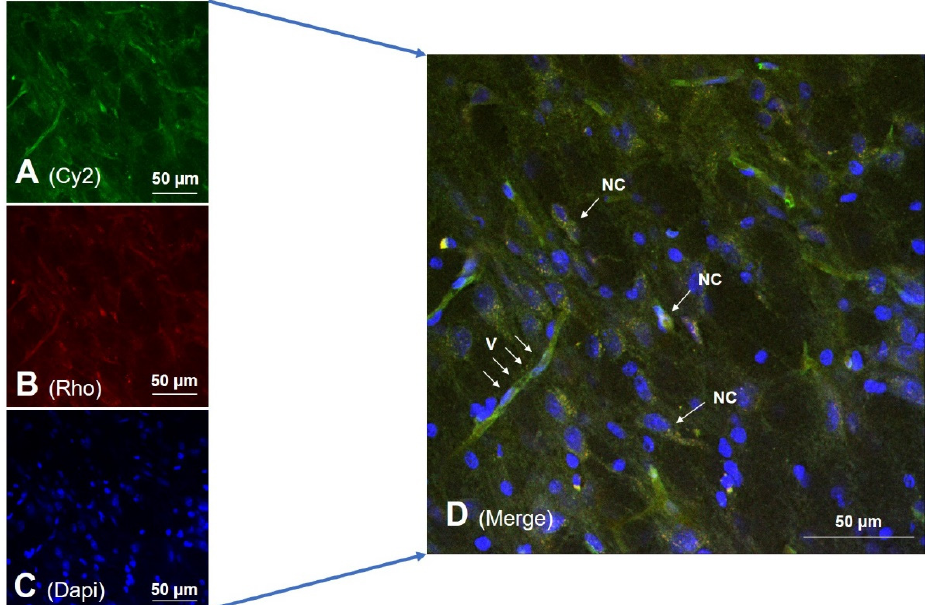
Figure 5. Ngb-NPs. Confocal microscopy images from the infarcted zone of MCAO animals taken 2 h after the systemic injection of the Ngb-NPs. Both the Ngb and NPs were colocalized in the vascular network and nervous cells of the injured brain parenchyma. ( A ) Cy2 green fluorescence represents Ngb. ( B ) Rhodamine red fluorescence detects NPs. ( C ) DAPI blue fluorescence marks cell nuclei. ( D ) Merge image showing the colocalization of Ngb and NPs inside vessels (V) and nervous cells (NC). Ngb-NPs appear in yellow, due to green and red merge.